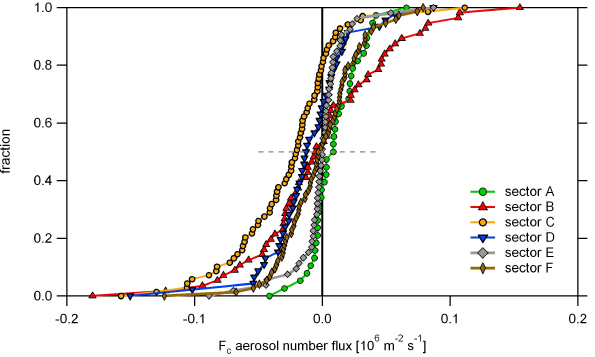
Fig. 3. Cumulative distribution of aerosol number fluxes in six dif- ferent sectors. Flux value at fraction of 0.5 is the median aerosol number